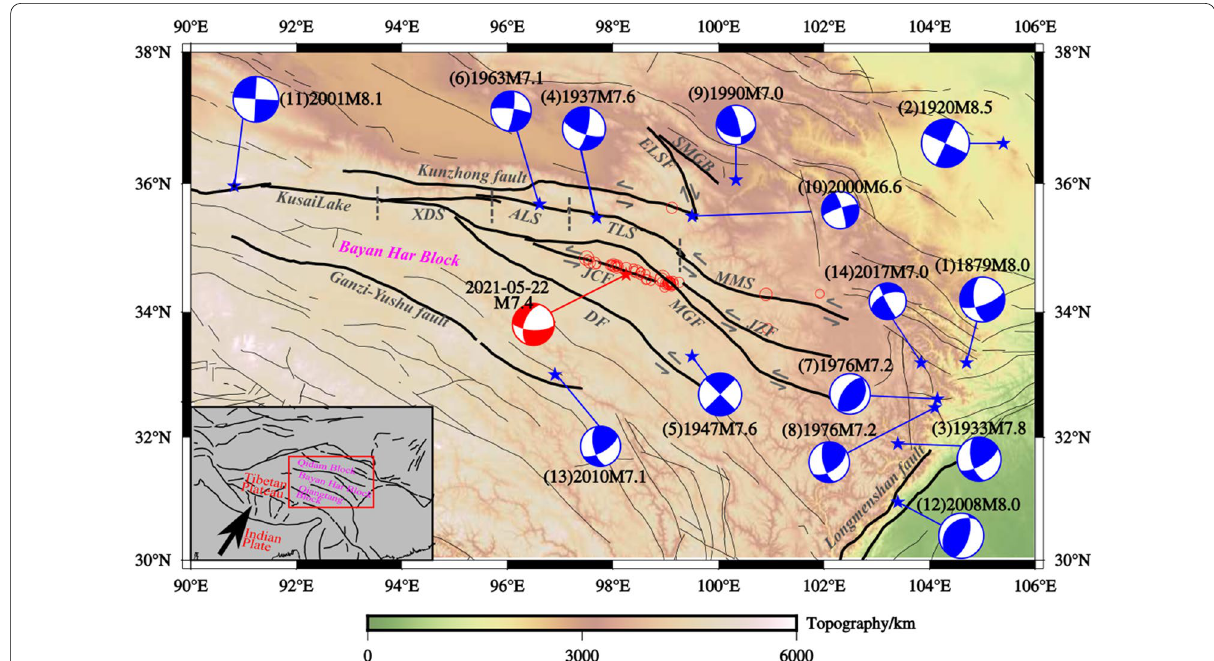
Fig. 1 Tectonic setting, wherein the blue stars show epicenter of the M > 6.5 earthquakes spatial distribution on and around EFK; the red star shows the 2021 Maduo earthquake epicenter; the beach balls define the earthquake focal mechanism; the black solid lines define the faults. SMGB: South Margin Fault of Gonghe Basin; ELSF: Ela Shan Fault; KZHF: Kunzhong Fault; KSL: Kusai Lake segment of east Kunlun Fault; XDS: Xidatan-Dongdatan segment; ALS: Alake Lake segment; TLS: Tuosuo Lake segment; MMS: Maqu-Maqin segment; JZF: Jiangcuo Fault; MGF: Maduo-Gande Fault; DF: Dari Fault; GZ-YS: Ganzi-Yushu Fault; LMS: Longmenshan Fault. The detailed earthquake parameters (focal depths, focal mechanisms) are summarized in Table 1. The lower left inset presents the location of target area in the larger geological